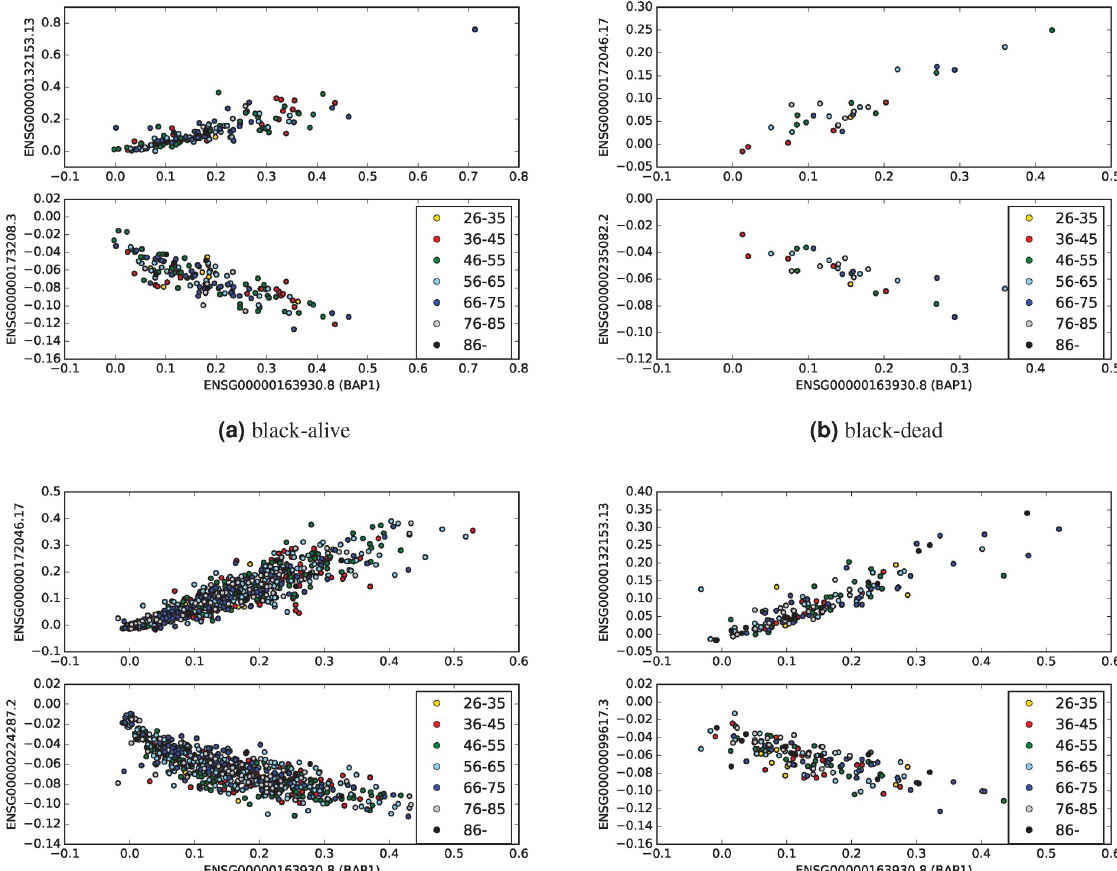
Fig 3. Highly correlated genes with BAP1 in BRCA sub-categories. In each panel, the top sub-figures show the scatter plot of the values of BAP1 and the gene, which has the maximum positive correlation with BAP1 in the given BRCA sub-category. The bottom sub-figures shows the scatter plot of the values of BAP1 and the gene, which has the maximum negative correlation with BAP1 in the given